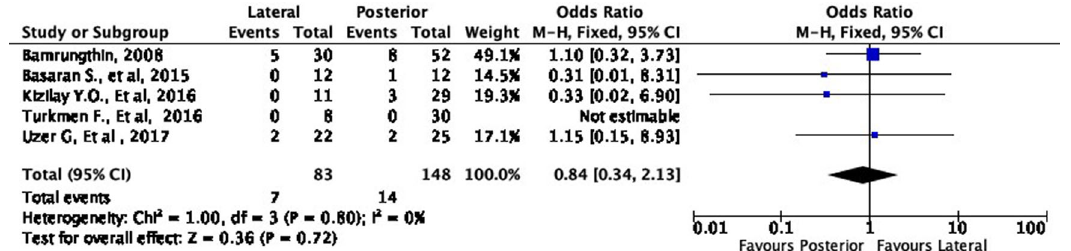
Figure 6. Comparison of functional outcome in the fair